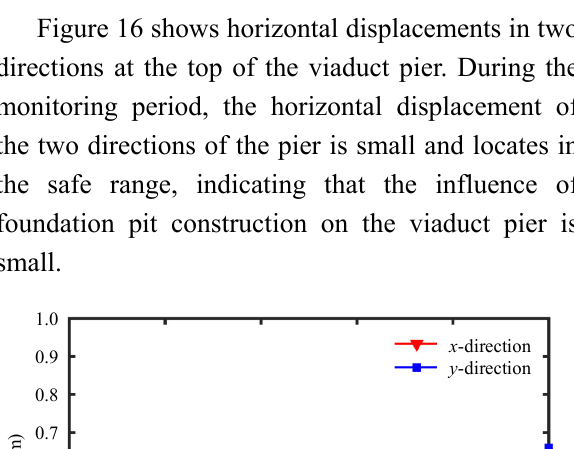
Fig. 15 Monitoring system and principle of the field test.